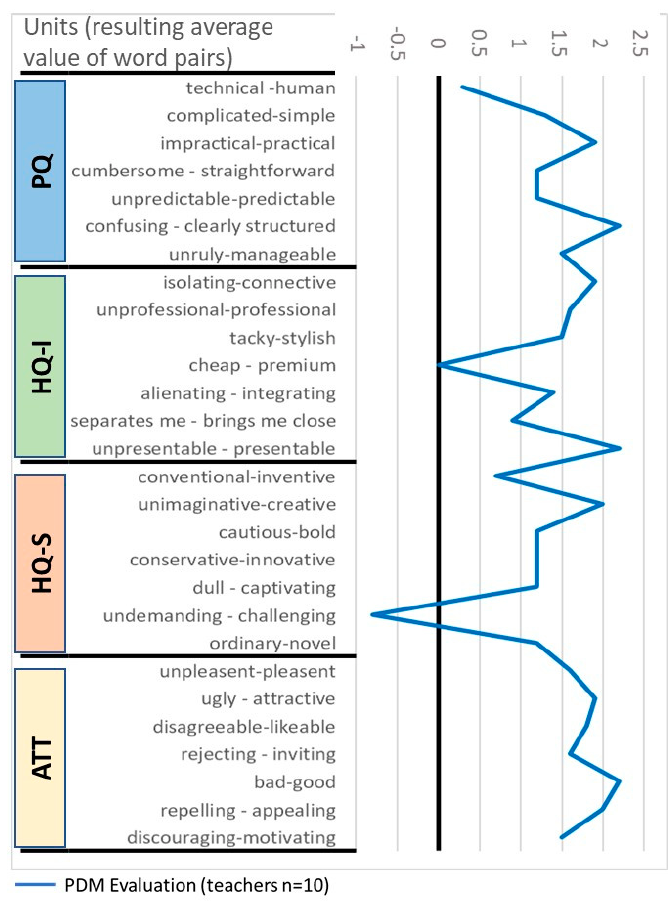
Figure 6. Diagram of the average of word pairs averages grouped by pragmatic qualities (PQs), hedonic identity quality (HQ-I), hedonic stimulation quality (HQ-S), and attractiveness (ATT) for the study 3.2.2.